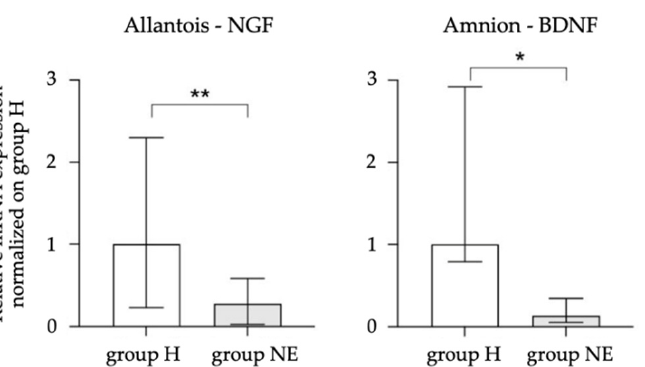
Figure 5. Differences in nerve growth factor ( NGF ) and brain-derived neurotrophic factor ( BDNF ) relative mRNA expression normalized on healthy foals between H and NE groups in allantois and amnion, respectively. * p < 0.05; ** p < 0.01.